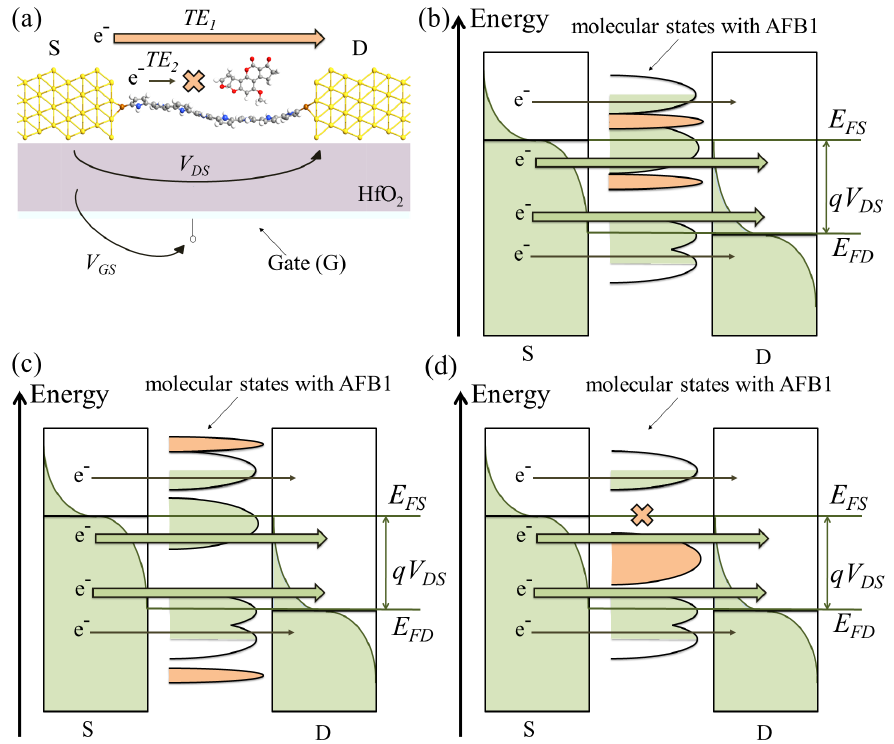
Figure 4. ( a ) Pictorial representation of the perturbation on the single-molecule FET caused by the target molecule (e.g., AFB1). The transmission, thus TEs , is altered. In this example, the presence of the target molecule enhances the transmission through TE 1 and decreases the transmission through the TE 2. Pictorial representations of the cases in which AFB1 significantly affects TS within the BW ( b ); outside the BW , thus producing no relevant I DS variations ( c ); and within the BW while a compensation produces no relevant I DS variations ( d ). In the latter case, the presence of AFB1 reduces an existing TS peak (orange cross) and enhances another TS peak (orange peak). The effects of AFB1 are highlighted in